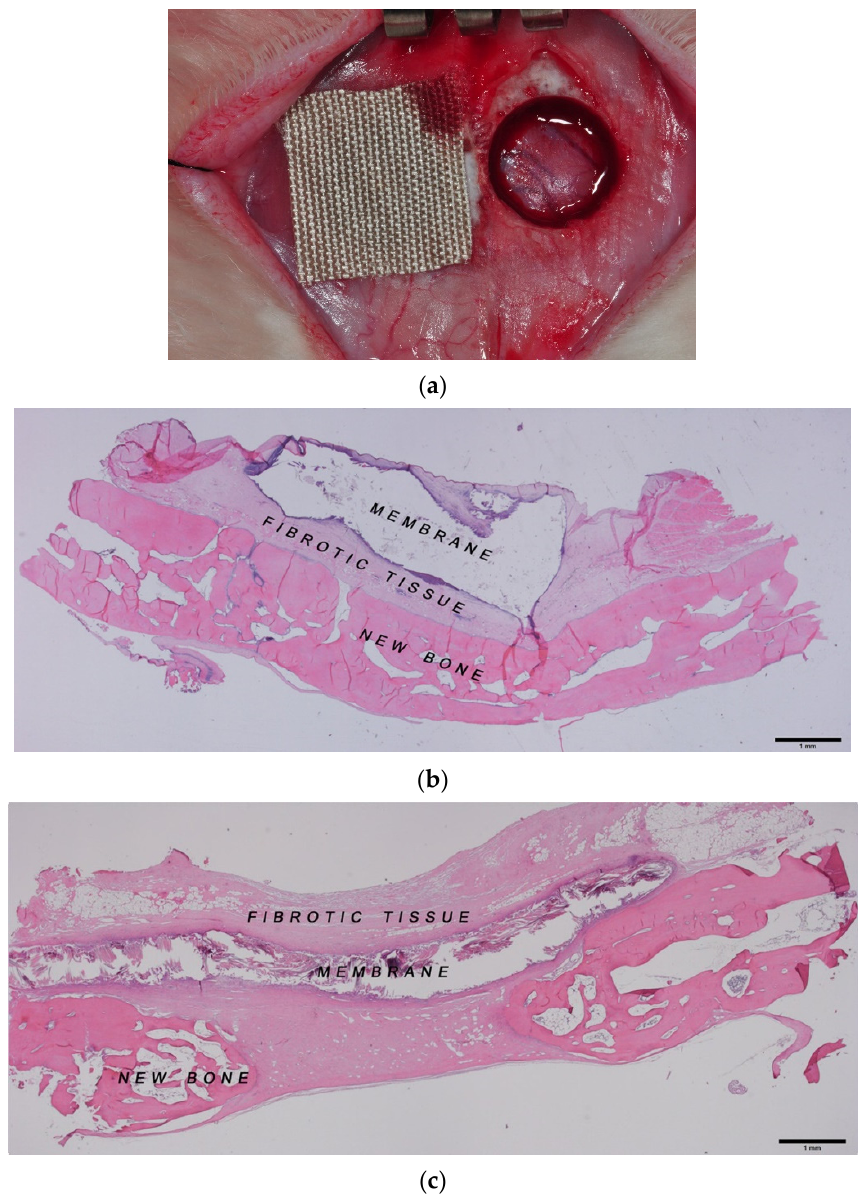
Figure 3. ( a ) For bilateral parietal bone defects of rabbits, either an 4-HR-incorporating silk fabric membrane (SFM) or a conventional SFM is placed on calvarial defect. Some defects remain uncovered as controls. Histological images 8 weeks after operation: ( b ) 4-HR-incorporating SFM; ( c ) conventional SFM (hematoxylin and eosin stain, scale bar = 1 mm; SFM: silk fabric membrane) Reproduced with permission from Lee, S. W. [41] .